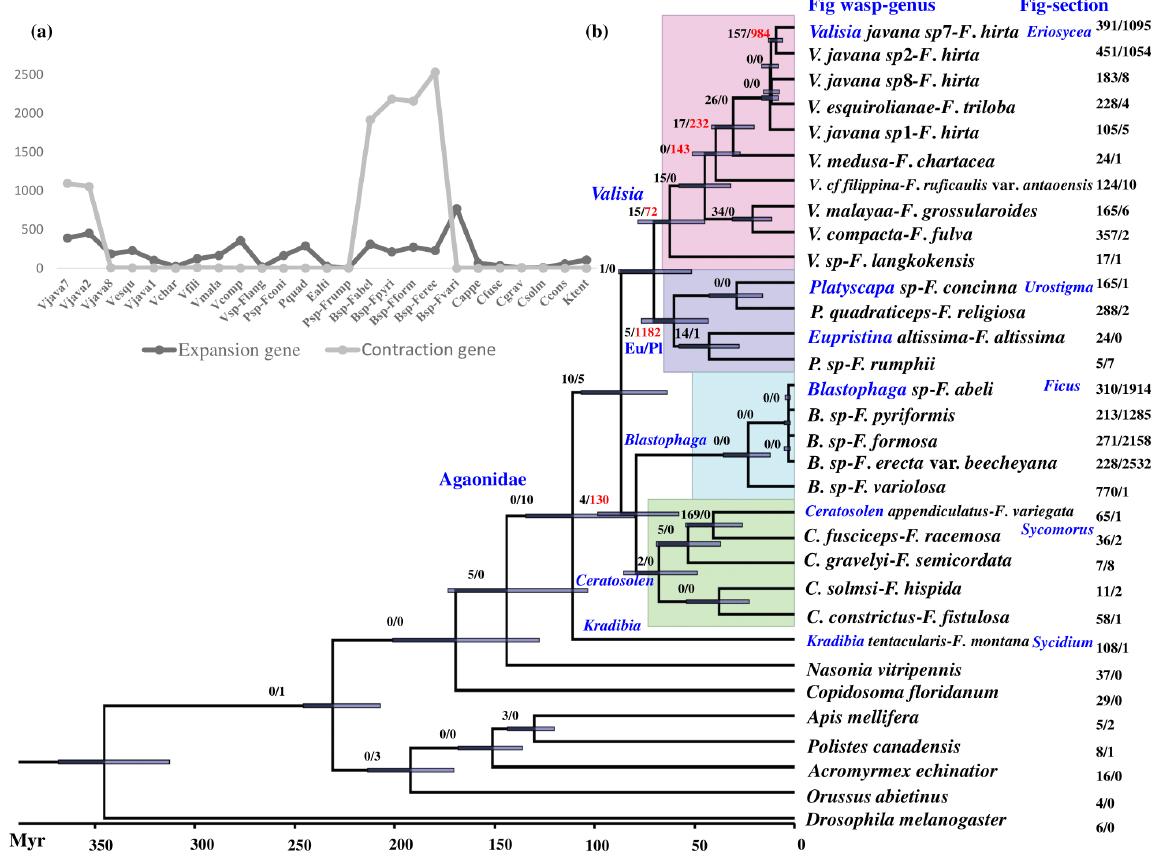
Figure 2. Phylogenetic relationships with gene-family clusters of 25 fig wasps and 7 other insect species: ( a ) comparison of the numbers of expanded (dark line) and contracted (light line) gene families among 25 fig wasps (nodes represent the number of gene families); ( b ) the resultant phylogenetic relationships, including divergence time and the number of expanded/contracted gene families in internal branches and tips (large numbers of contracted gene families are shown in red). Taxonomic information is also given in blue for each clade. Myr means one million years.